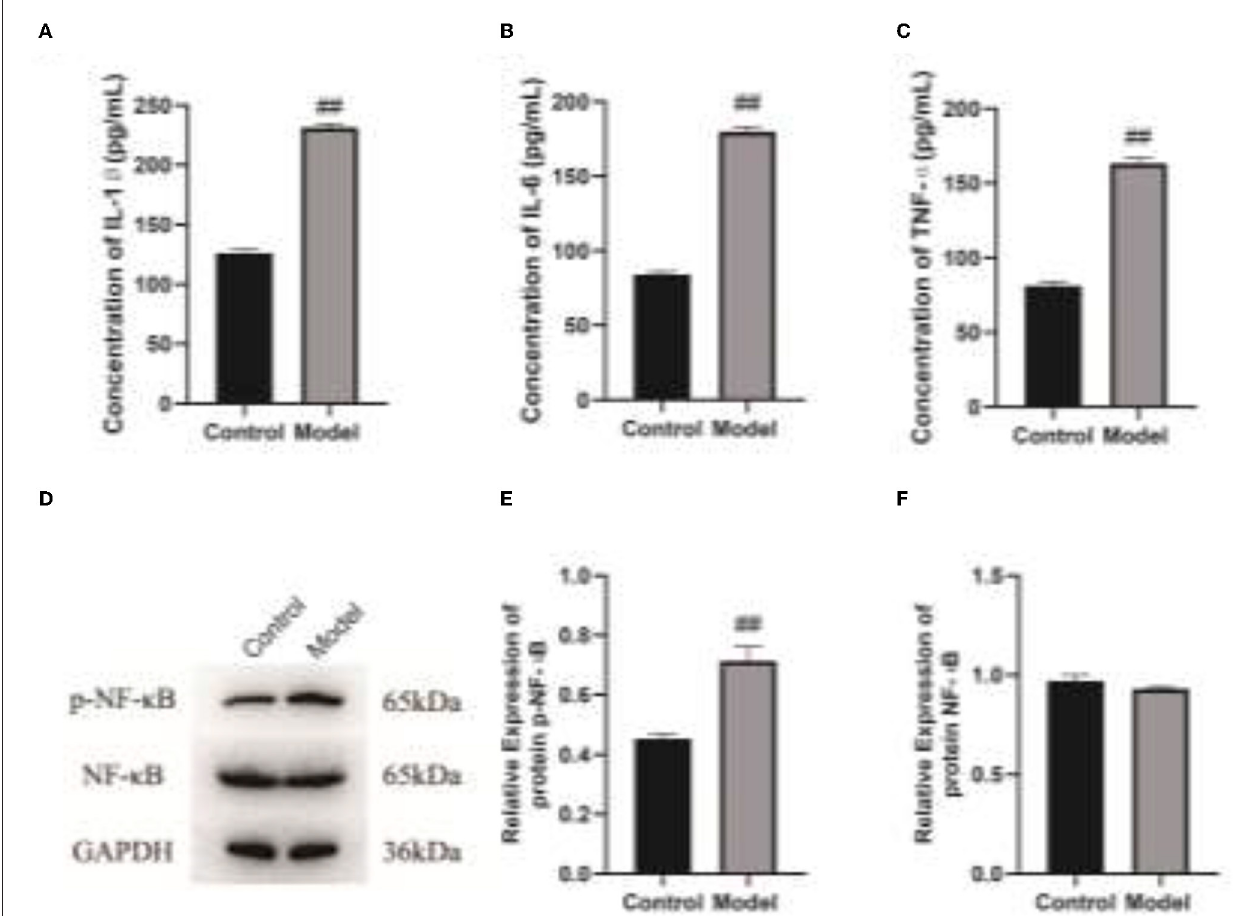
FIGURE 6 | Veillonella parvula regulates the expressions of inflammatory factors. (A–C) , Expressions of IL-1, IL-6, and TNF- α detected by ELISA. (D) , The expressions of NF- κ B and p-NF- κ B detected by Western blot. (E,F) , Gray value analysis of NF- κ B and p-NF- κ B proteins. ## p < 0.01. IL-6, interleukin-L; TNF- α , Tumor Necrosis Factor α ; ELISA, enzyme-linked immunosorbent